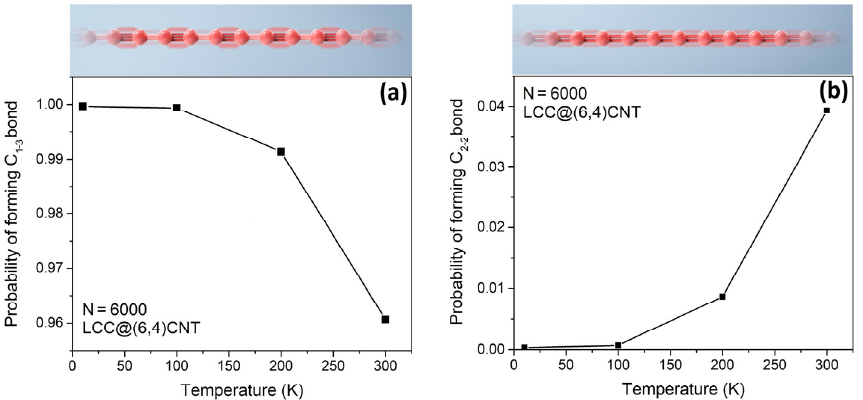
Figure 2. An LCC encapsulated by a (6,4)CNT upon heating. The LCC is made up of 6000 atoms. ( a ) The probability of maintaining a polyyne phase in the carbon chain. The C 1–3 bond is defined as the formation of a single bond and a triple bond alternatingly. The red chain shows the structure of polyyne schematically. ( b ) The probability of maintaining a cumulene phase in the carbon chain. The C 2–2 bond is defined as the formation of consecutive double bonds. The red chain refers to the schematic structure of cumulene.